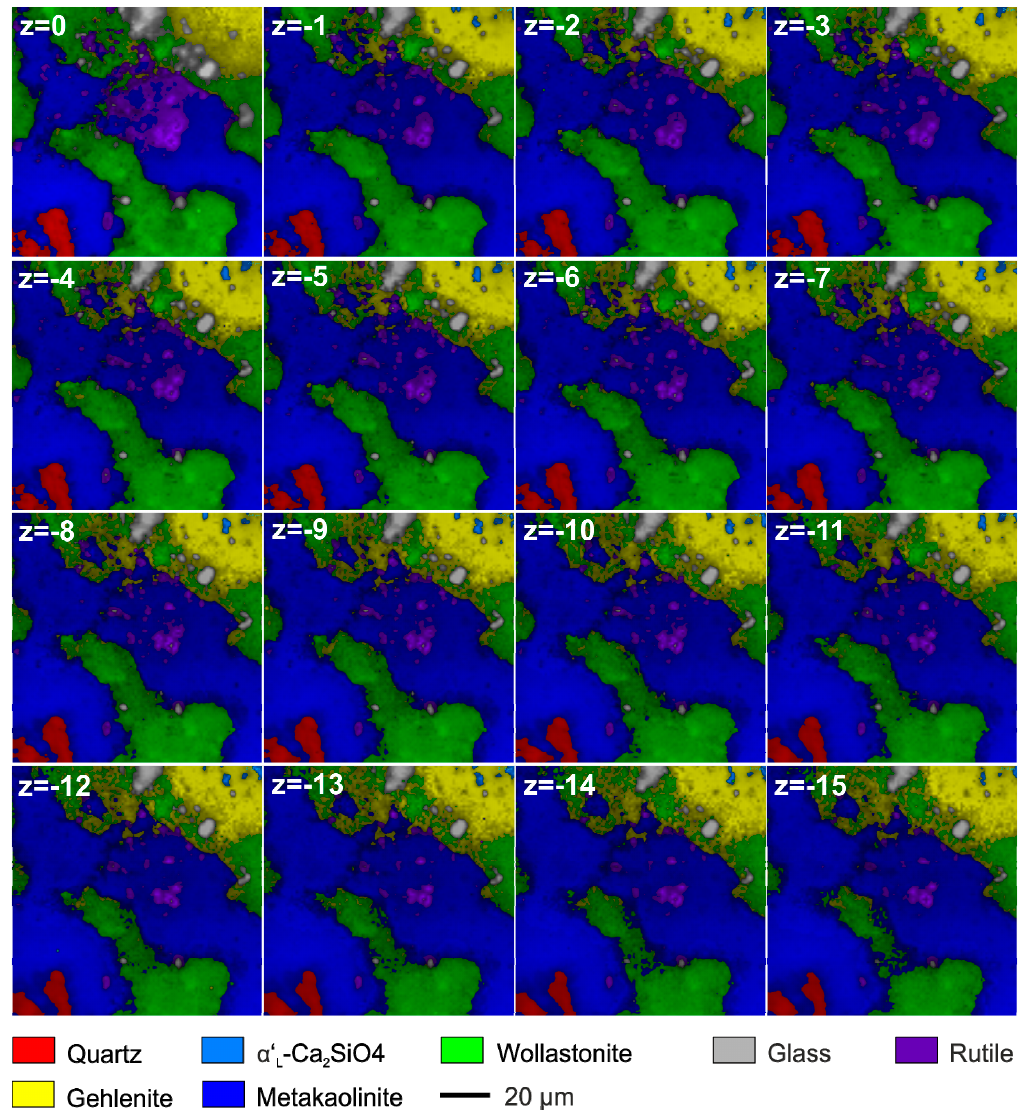
Figure 11. A series of 16 hyperspectral Raman images of a fired ceramic that were recorded with a nominal depth z = 0 (focus at the surface) and z = − 15 µ m (focus 15 µ m below the surface). Note that despite the significant offset of the focus all images exhibit the same relative phase proportions and main morphological details.